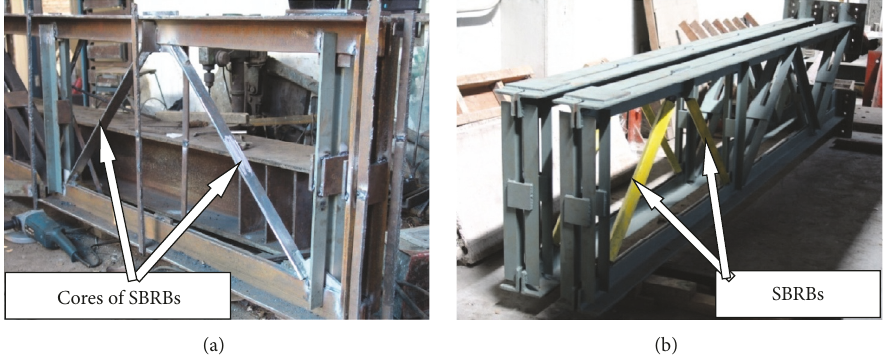
Figure 10: (a) The cores of SBRBs before being cased in the tubes. (b) SBRBs as components of BRB-TMF